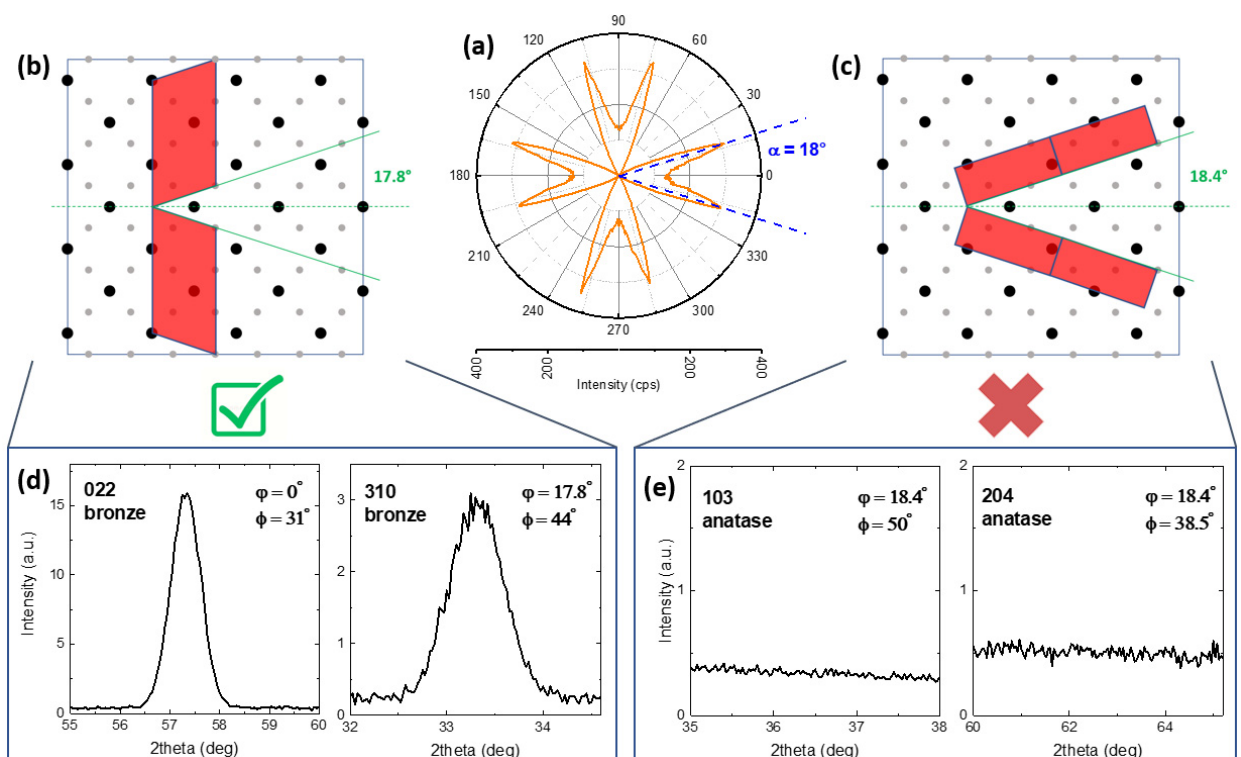
Figure 3. ( a ) φ -scan at 2 θ = 25.1° and ϕ = 18°. At these goniometer parameters, the 110 reflection of a b-axis-oriented bronze film and the 101 reflection of an a-axis-oriented anatase film would be expected. The two epitaxial configurations are illustrated in ( b , c ), respectively. In both cases, twinning would lead to a double peak structure with 4-fold symmetry as seen in ( a ). The stabilization of the bronze phase is confirmed via 2 θ scans around the 022 and 310 bronze reflections, as shown in ( d ). ( e ) Scans along the 103 and 204 anatase reflections show no film peaks and indicate that no anatase is present.